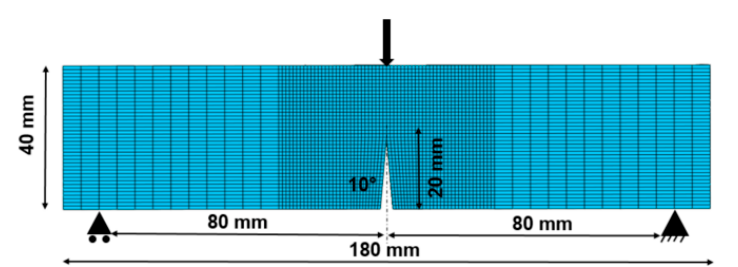
Figure 10 . Deposition trajectories from the G code of the SENB specimen after applying the opti- mization method on the V notch vicinity. ( a ) First principal direction and ( b ) second principal di- rection.